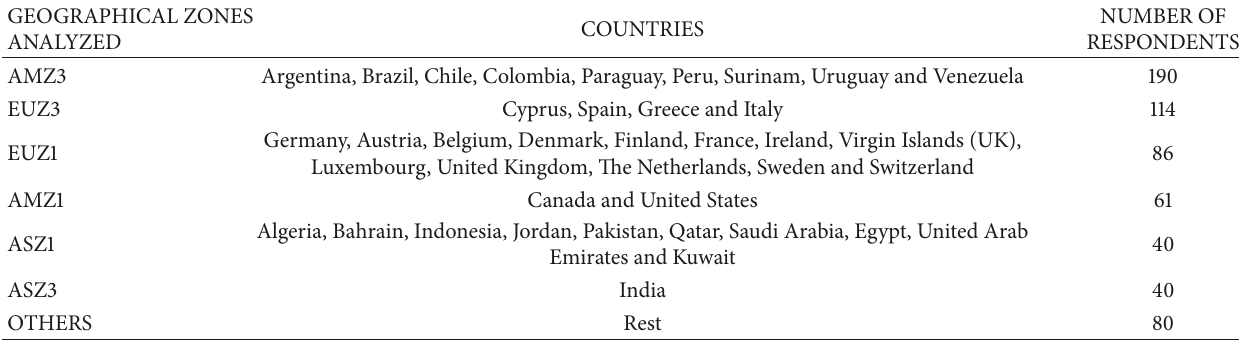
Table 4: Answers grouped by geographical zone.